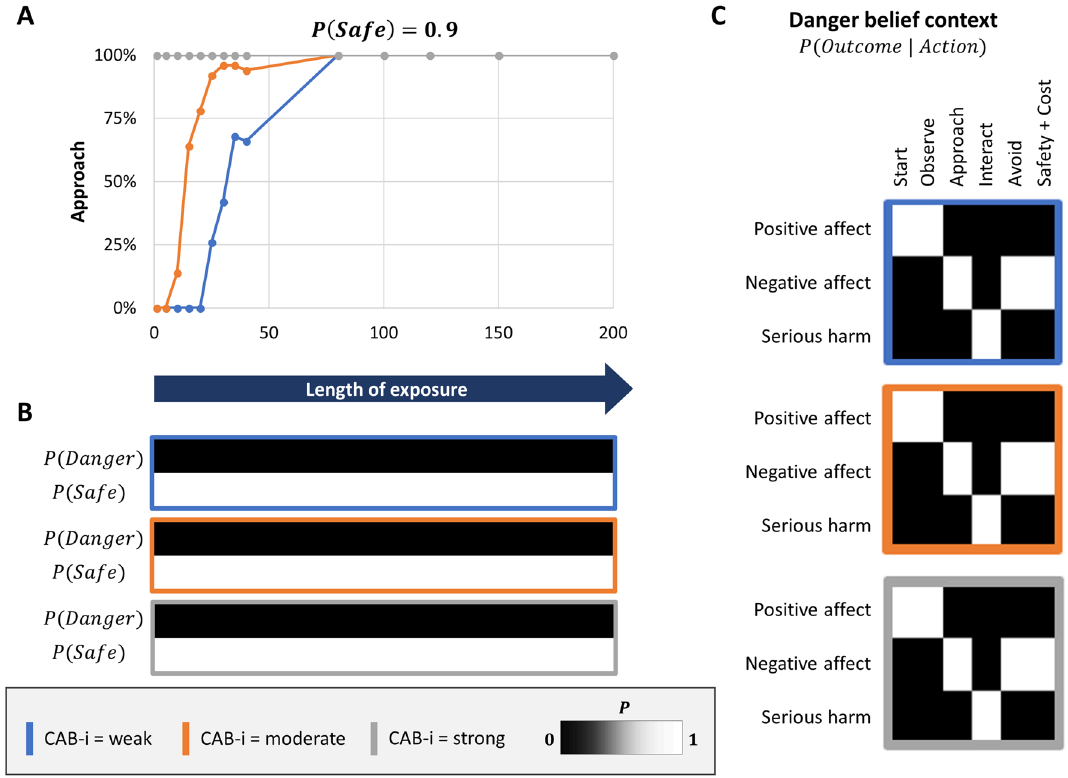
Figure 5. Exposure therapy under strong explicit safety beliefs (i.e., such as after cognitive restructuring; P ( safe ) = .9 ) and different CAB interaction strengths. When CAB interactions were strong (grey outline), approach behavior was present immediately (panel A ). Under moderate or weak CAB interactions (orange or blue outline), behavior change occured rapidly. Implicit beliefs (panel C ) associated with explicit beliefs in danger (panel B ) remained unchanged, creating a vulnerability to the re-emergence of negative affective responses and avoidance behavior in other contexts (i.e., upon the return of thoughts of danger). CAB-i = parameter encoding the efficacy of cognition-affect-behavior interactions; Safety + Cost = reaching safety along with opportunity costs that promote negative